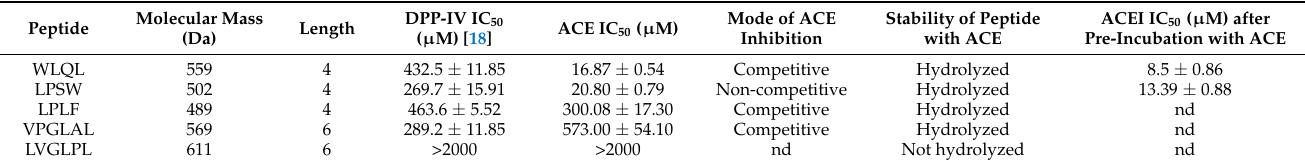
Table 1. DPP-IV and ACE inhibitory activity of five peptides derived from SSTY protein